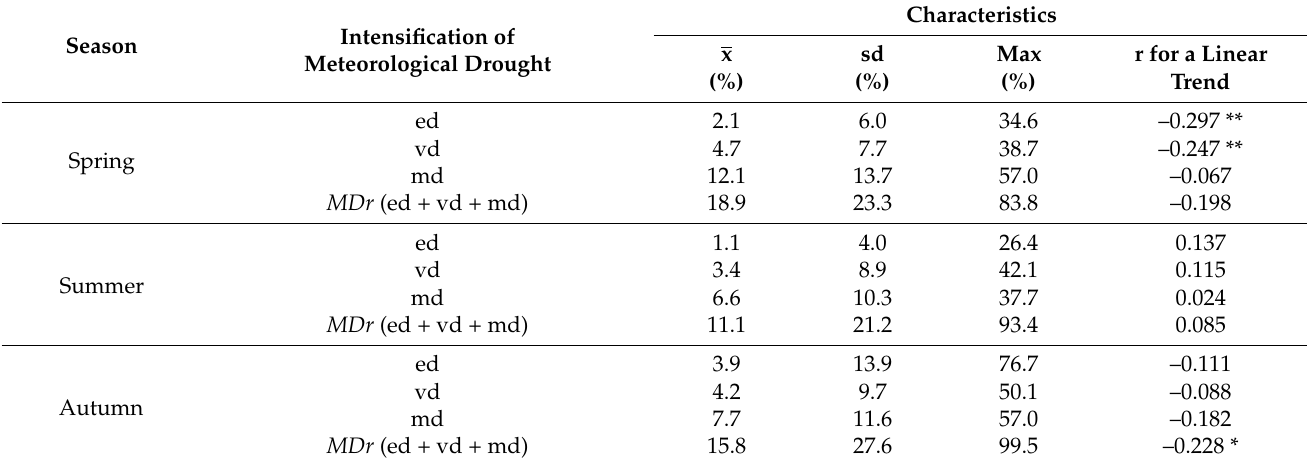
Table 2. Characteristics of Poland’s area affected by meteorological drought ( AAMDr ), determined on the basis of SPI-3 . Years